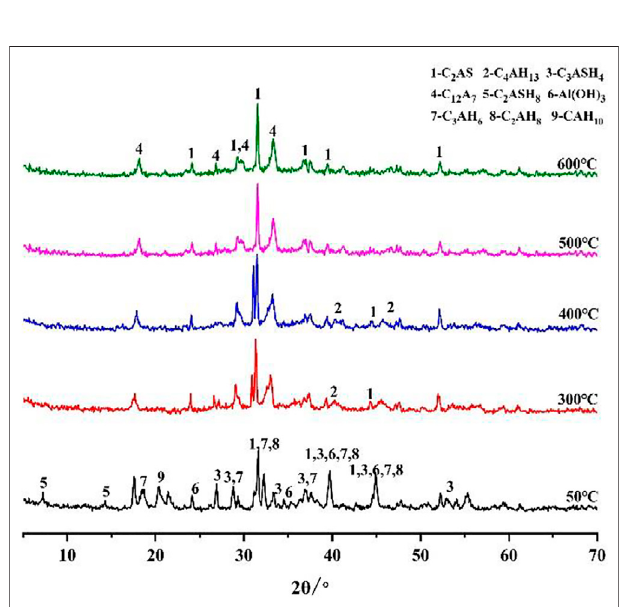
FIGURE 8 | XRD diffraction patterns of C1 cement paste under different curing environments.